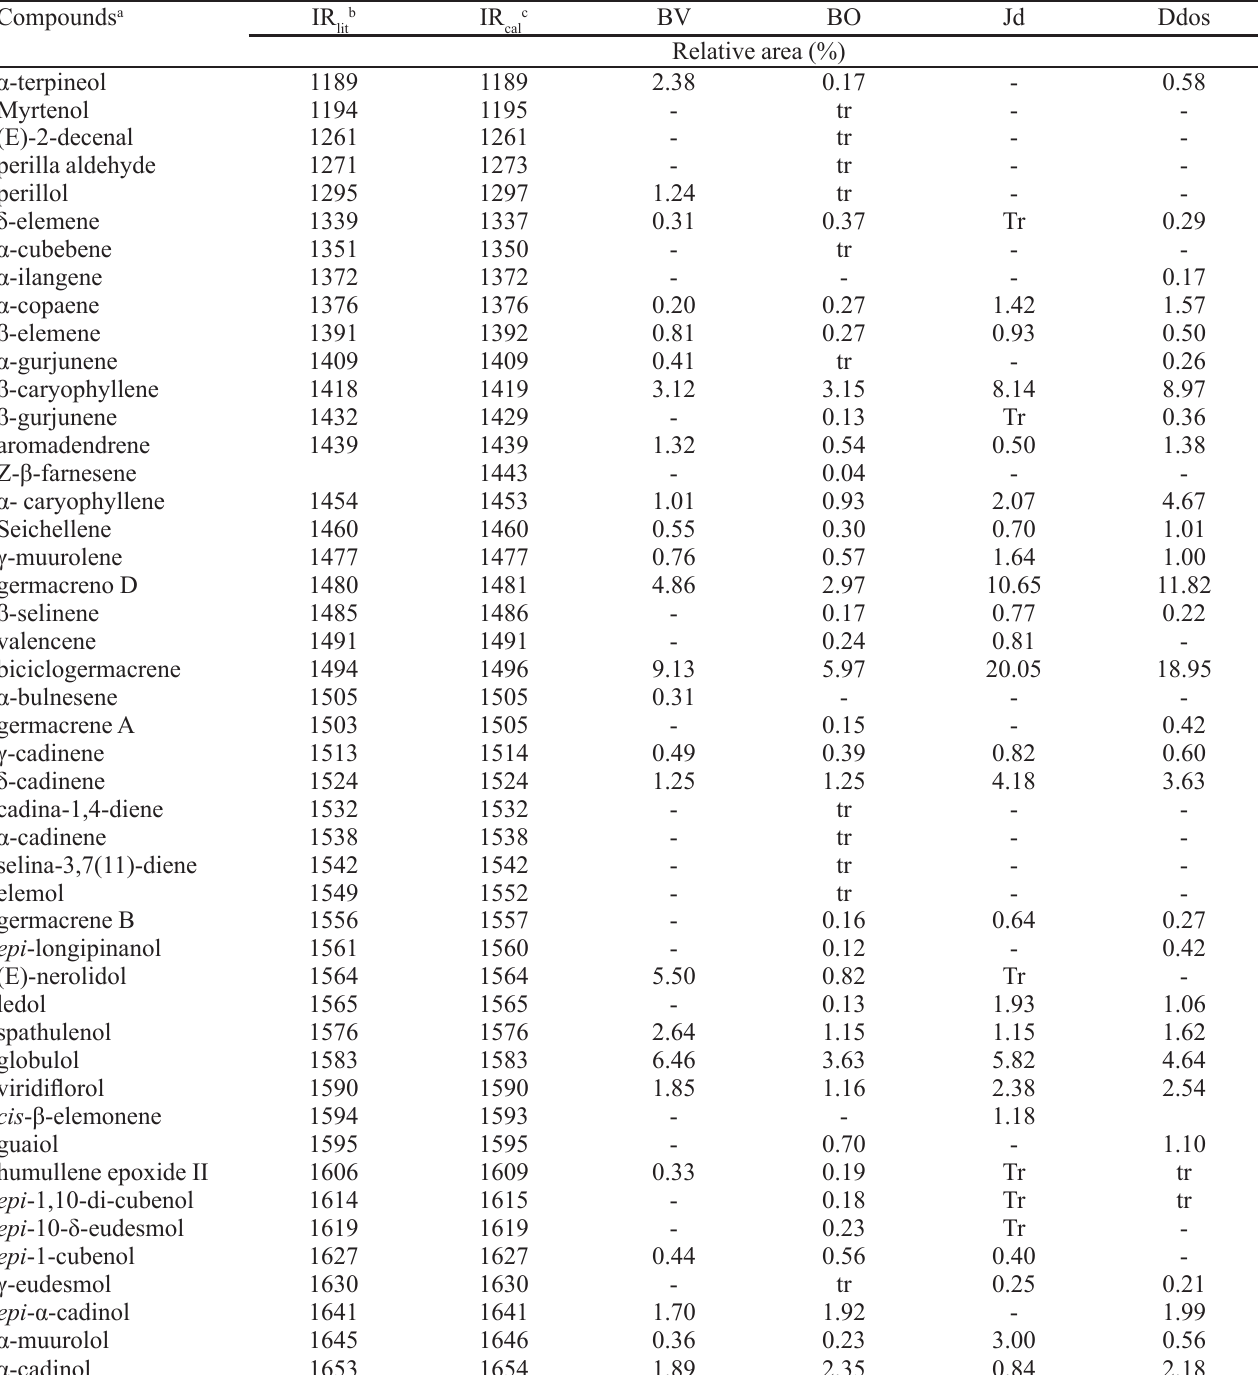
TABLE II - Compounds identified in the essential oil of Campomanesia adamantium leaves in different localities of Mato Grosso do Sul State, Brazil, during the fruit-bearing stage